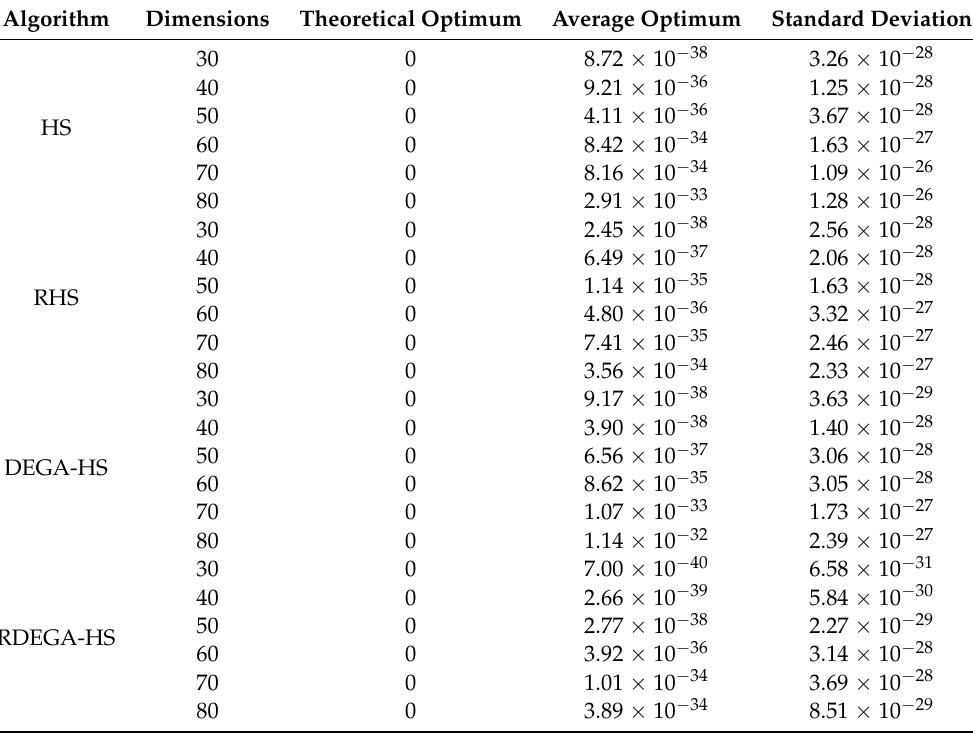
Figure 8. Change in average optimal fitness value of Sphere function with number of iterations. Table 8. Results of the Sphere function under different optimization